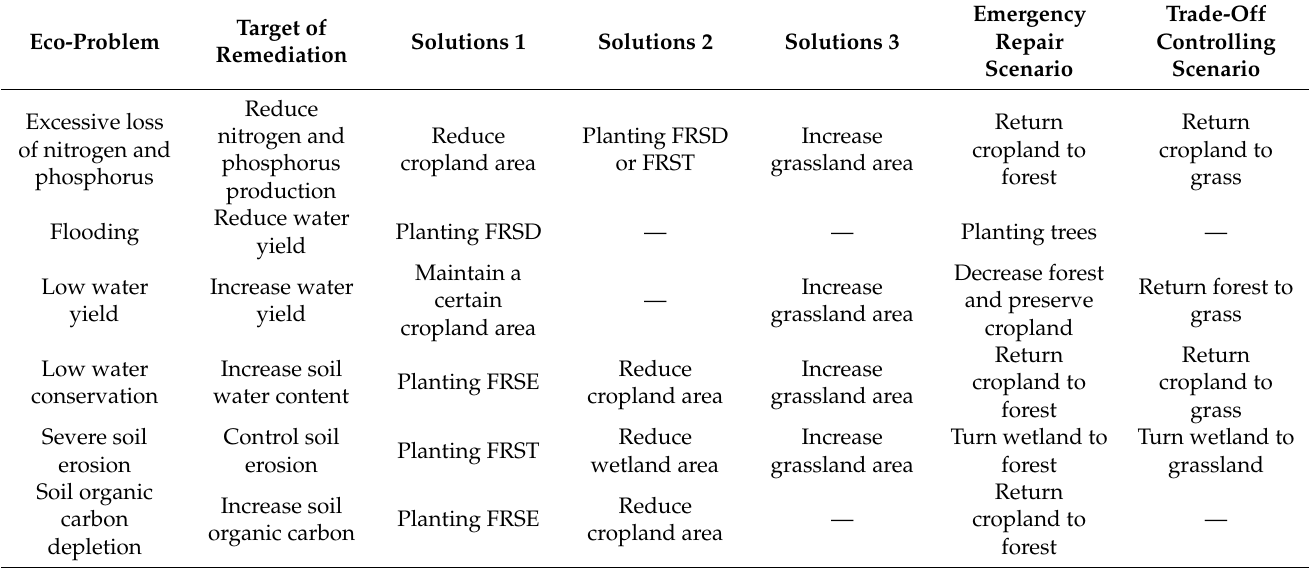
Table 8. Solutions for Different Ecological Problems and the Scenarios under Different Restoring Scheme Strengths Consisting of Different